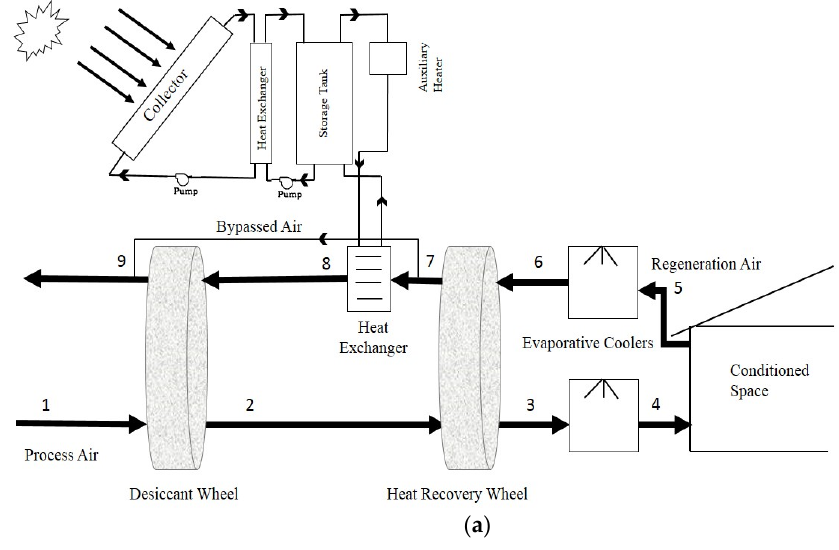
Figure 5. Cont. Figure 5.